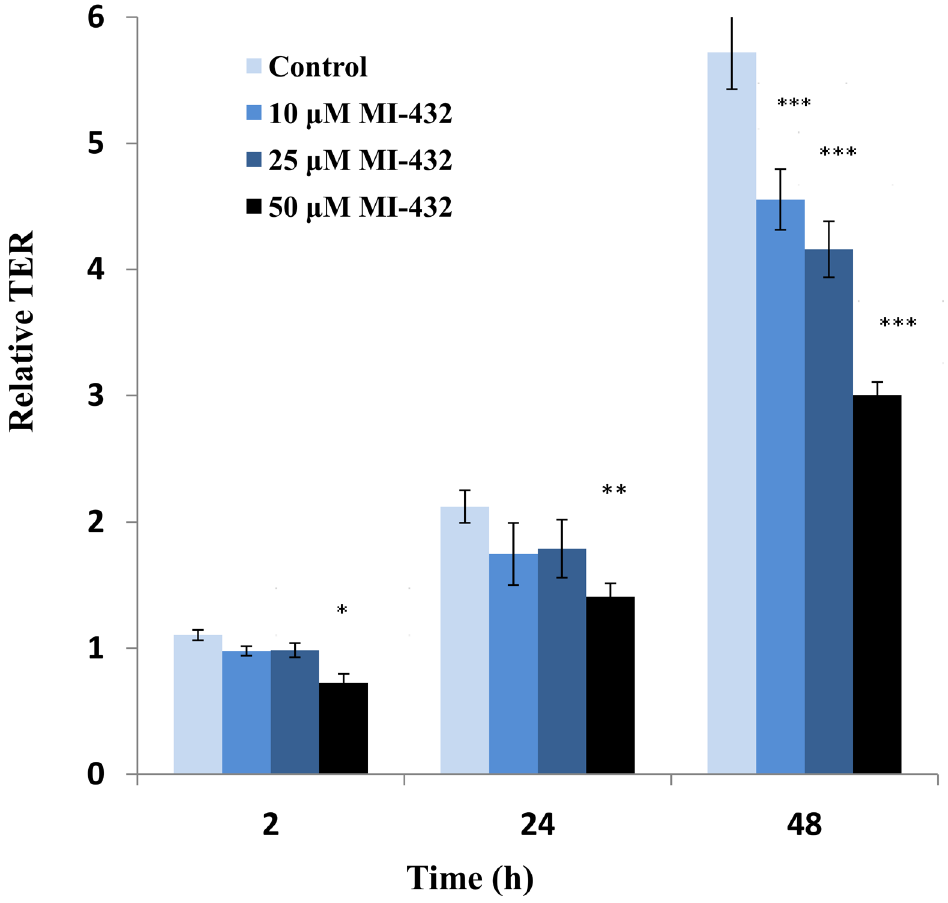
Fig 1. Relative TER (actual TER values divided by initial TERs) of both the control and the inhibited cell cultures (at 10, 25 and 50 μ M of inhibitor MI-432). At 2 hours ( * p < 0.05) and 24 hours ( ** p < 0.01) significant decreases in TER can be seen only with the 50 μ M concentration while at 48 hours, for all concentrations of MI-432 ( *** p < 0.001) there are significant decreases in the TERs when compared to control